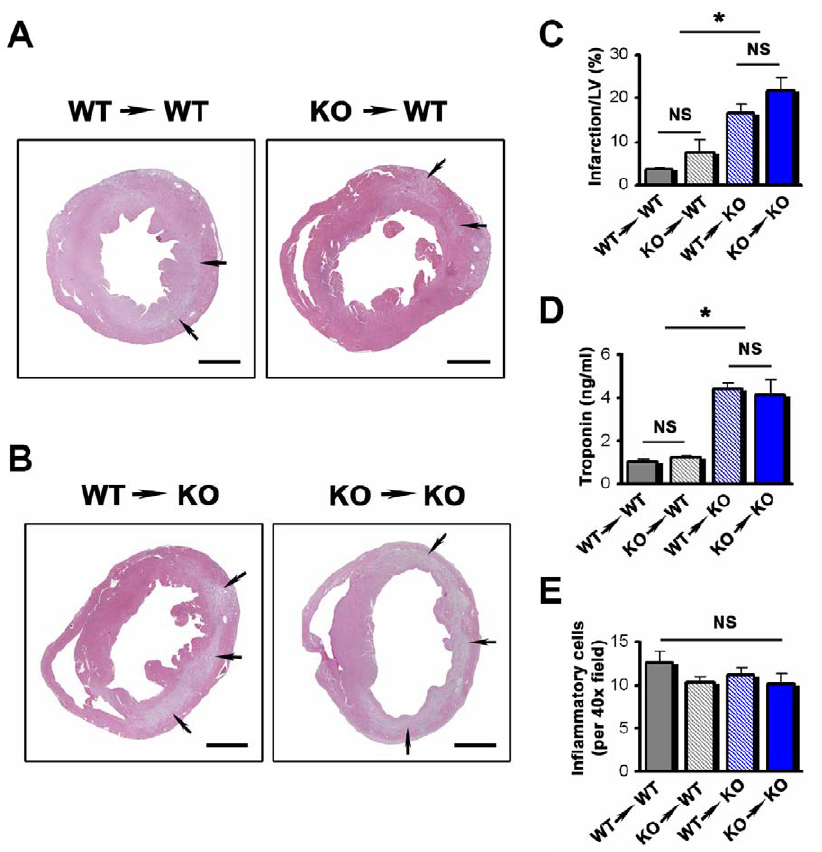
Figure 3. PI3K c functions in non-haematopoietic cells in myocardial ischemia/reperfusion injury. ( A ) Representative left mid-ventricular histological sections (H&E staining) from WT mice receiving WT bone marrow (WTWT) and WT mice receiving PI3K c 2 / 2 bone marrow (KOWT). Hearts were isolated and analysed from mice 1 week after M I/R injury. Arrows indicate areas of infarction. ( B ) Representative left mid-ventricular histological sections (H&E staining) from PI3K c 2 / 2 mice receiving WT bone marrow (WTKO) and PI3K c 2 / 2 mice receiving PI3K c 2 / 2 bone marrow (KOKO) after 1 week of M I/R injury. Arrows point at areas of infarction. ( C ) No significant difference between WTWT and KOWT chimeras and no difference between WTKO and KOKO chimeras in the size of infarction determined 1 week after M I/R injury. n=5 per group. ( D ) No significant difference between WTWT and KOWT chimeras and no difference between WTKO and KOKO chimeras in TroponinT levels assayed 3 hours after reperfusion. n=7 per group. ( E ) No significant difference between all 4 groups of chimeric mice in the numbers of infiltrating inflammatory cells 1 week after M I/R. n=5 per group. In all histological pictures the bar indicates 1 mm. All bar graphs show mean values + / 2 SEM. *p , 0.05. NS=no significant difference.